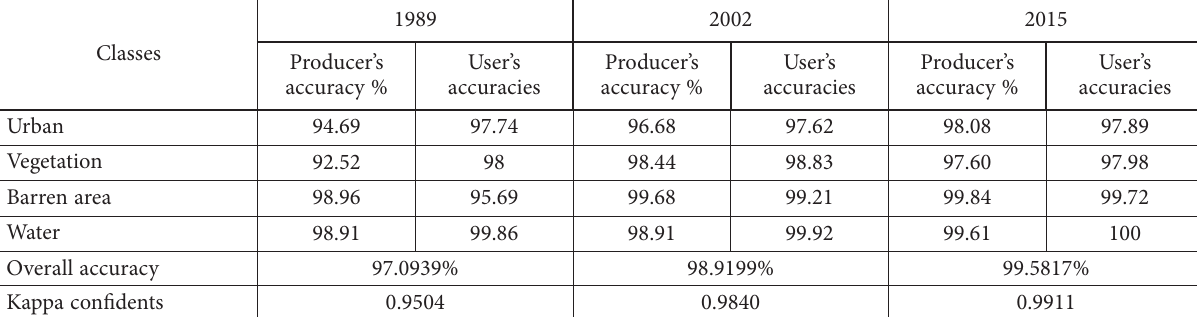
Table 3. Error Matrix (%) comparing the image classification of 1989, 2002, and 2015 to the reference